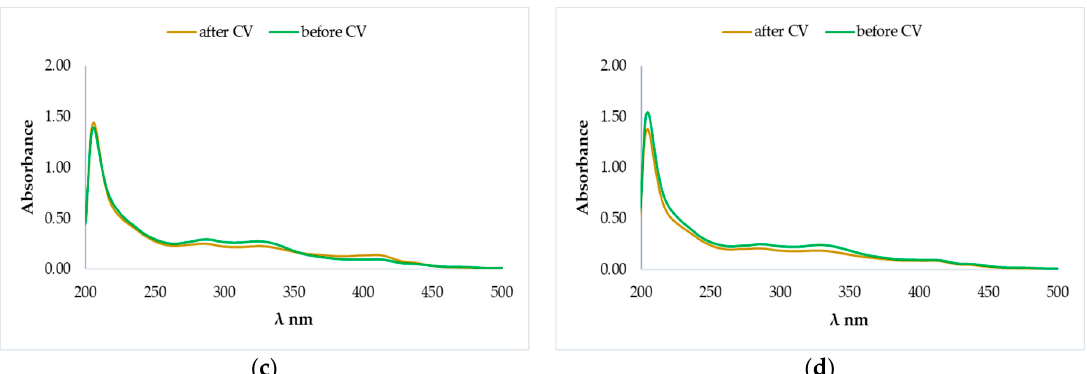
Figure 7. UV-VIS spectra recorded for the samples before and after cyclic voltammetry experiments: “Aromat de Buzau” methanolic extract ( a ) and ethanolic extract ( b ), “Macedon” methanolic extract ( c ) and ethanolic extract ( d ).